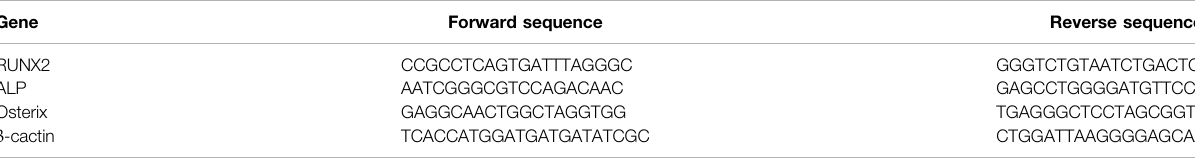
TABLE 1 | List of gene